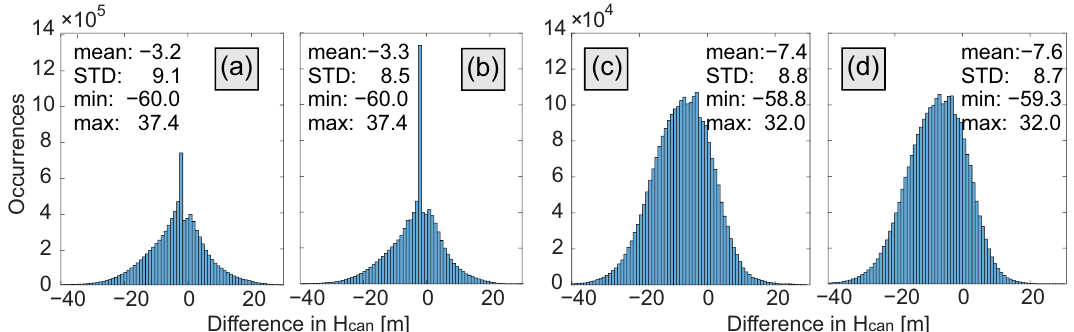
Figure 10. Histograms and statistics of differences in canopy heights between two canopy models and LVIS data (ZT-ZG)): ( a ) CHM2000 versus LVIS2005. ( b ) GFCH2019 versus LVIS2005. ( c ) CHM2000 versus LVIS1998. ( d ) GFCH2019 versus LVIS1998. The statistics is provided in terms of the mean difference, Standard Deviation (STD), and minimum (min) and maximum (max)